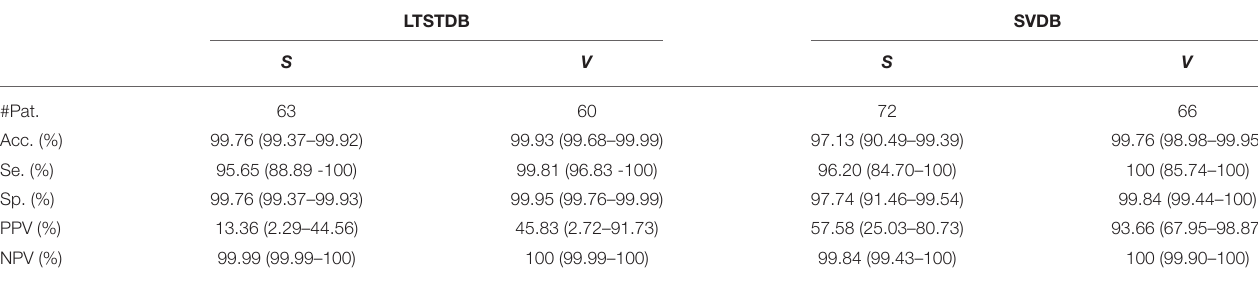
TABLE 6 | Patient-based classifier performance, median (IQR range) for the multi-class classification. LTSTDB SVDB S V S